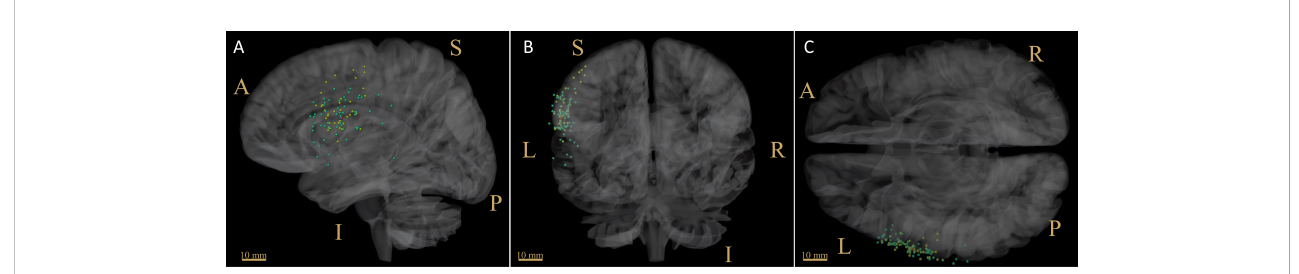
FIGURE 2 Distribution of language-positive sites derived from nTMS and DES. The green dots indicate the nTMS-positive sites, among which the CoG is shown in red. The yellow dots indicate the DES-positive sites, among which the CoG is shown in blue. (A) sagittal view; (B) coronal view; (C) cross view. CoG = center of gravity; scale bar = 10 mm; L, left; R, right; S, superior; I, inferior; A, anterior; P,